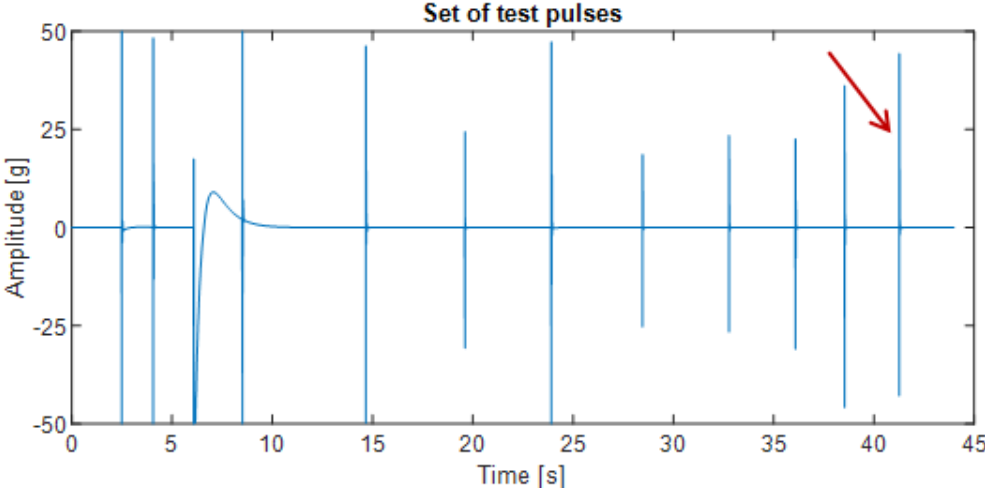
Figure 3. Selection of suitable pulse. The arrow indicates selected pulse.